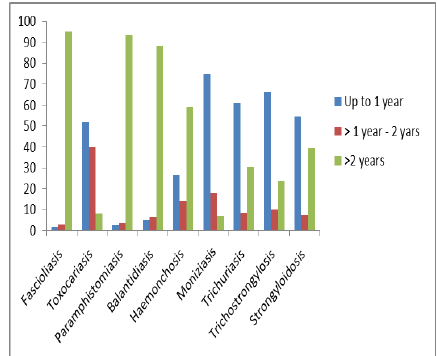
Figure-2. Proportion of gastrointestinal parasitism in cross-bred cattle at Sirajganj